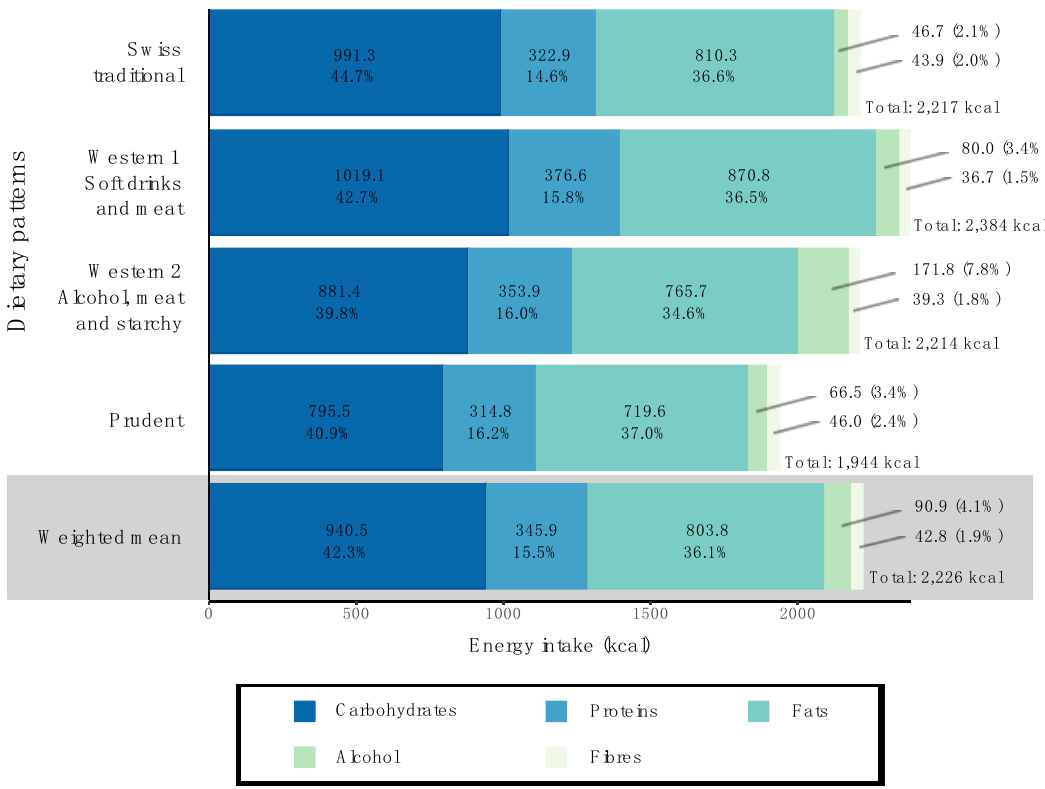
Figure 3. Macronutrient contributions to total energy intake in the four dietary patterns and the overall study population. Figures indicate the mean energy (in kcal) brought by macronutrients, alcohol and fibres and their contributions to the total energy intake. The weighted mean provides estimates of the mean energy in the study population after correction for sex, age, marital status, major area, household size, nationality and the uneven distribution of 24-h dietary recalls over seasons and weekdays.